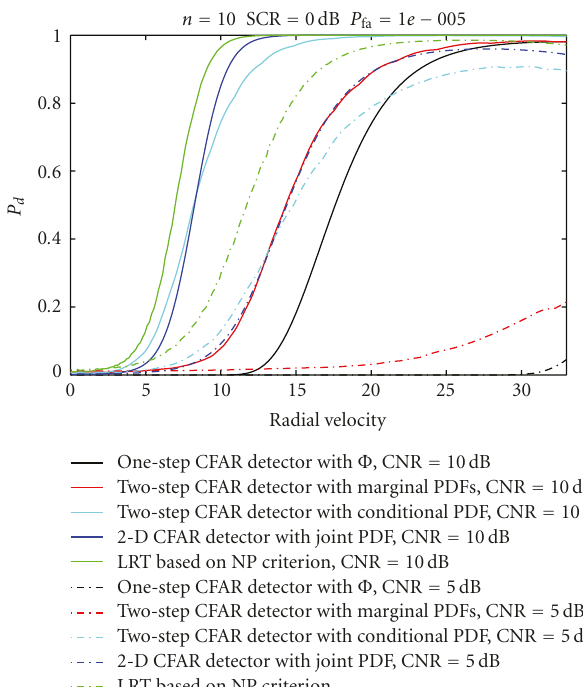
Figure 10: P d of ATI detectors versus radial velocity of moving target for n = 10, P fa = 1 e − 5 (two-step CFAR detector with conditional PDF (center point/maximum P d ), two-step CFAR detector with marginal PDFs (center point/maximum P d ), 2D CFAR detector with joint PDF, and LRT based on NP